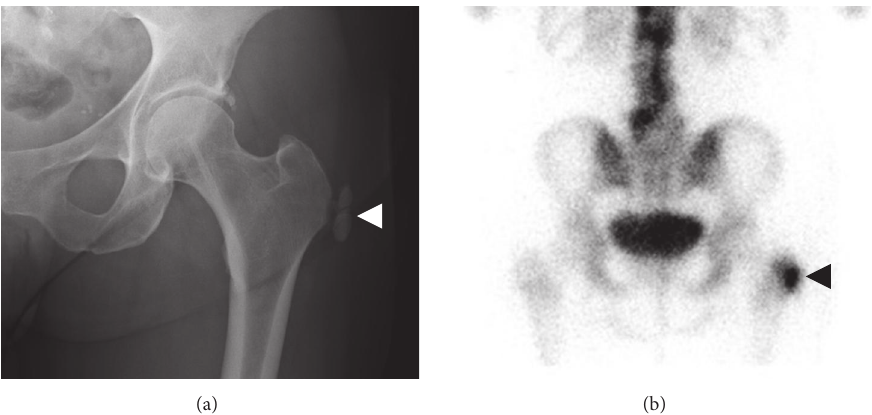
Figure 5: Appearance of calcific bursitis on technetium-99m bone scan. (a) A large conglomeration of soft tissue calcifications reside in the region of the left greater trochanter bursa on AP hip radiograph (white arrowhead). (b) The calcifications demonstrate exuberant increased